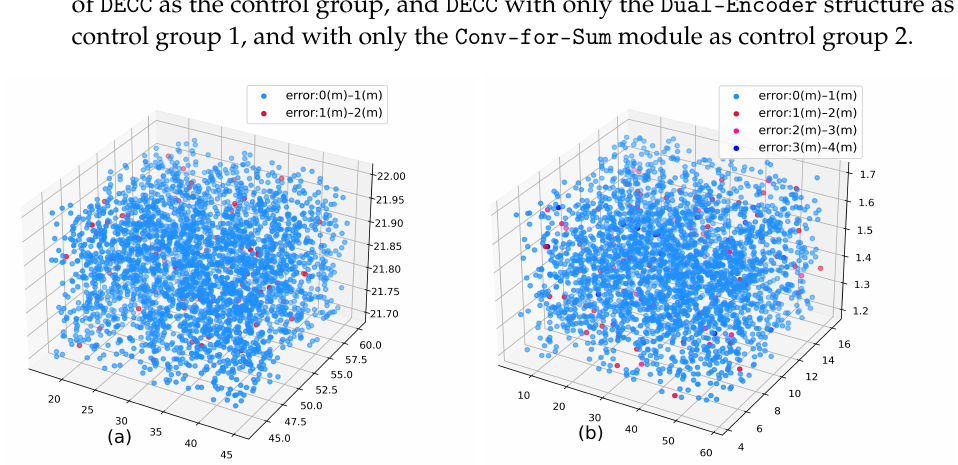
Figure 7. Visualized distance error: ( a ) the urban canyon scenario and ( b ) the indoor scenario.